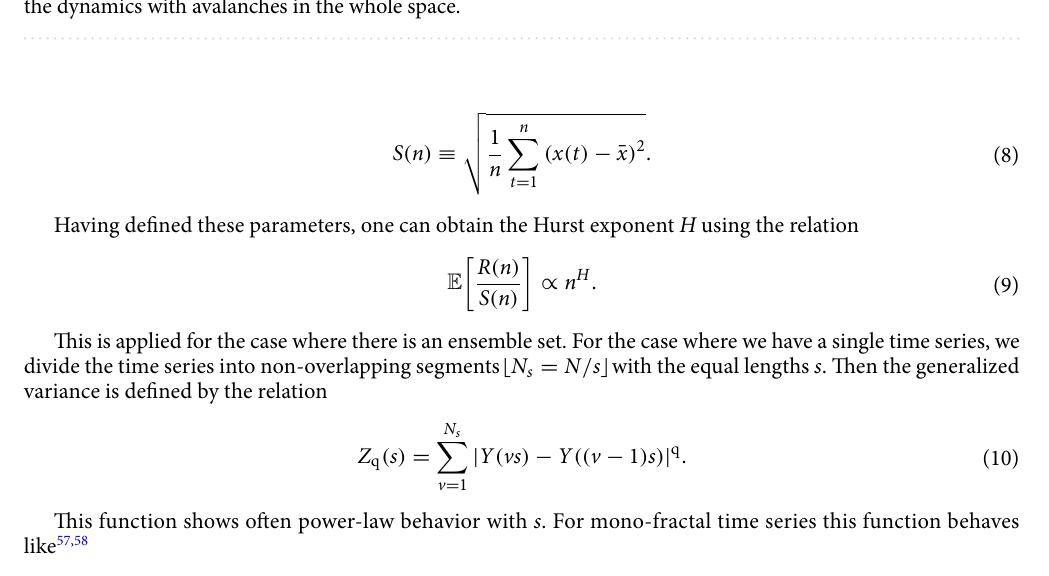
Figure 9. The distribution function of ( a ) avalanche size S , ( b ) avalanche duration D . (c) The log - log plot of S - D scaling relation. (d) Activity dependent branching ratio b ( x ) for instantaneous avalanche size x . All plots are for the dynamics with avalanches in the whole